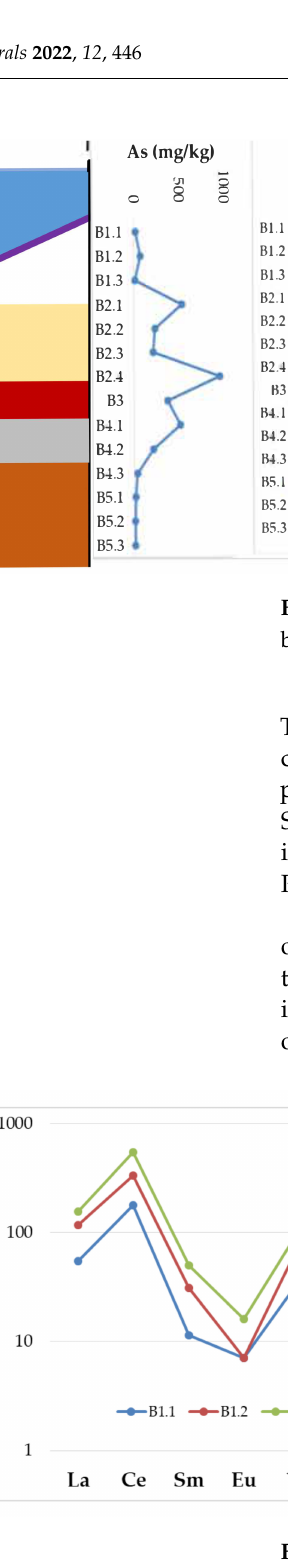
Figure 6. Chondrite-normalized REE patterns for bauxite samples from the Parnassos-Ghiona of varying color ( a ): Grey-whitish; ( b ): yellow and deep red; ( c ): deep grey and brown-red. Data are from Table